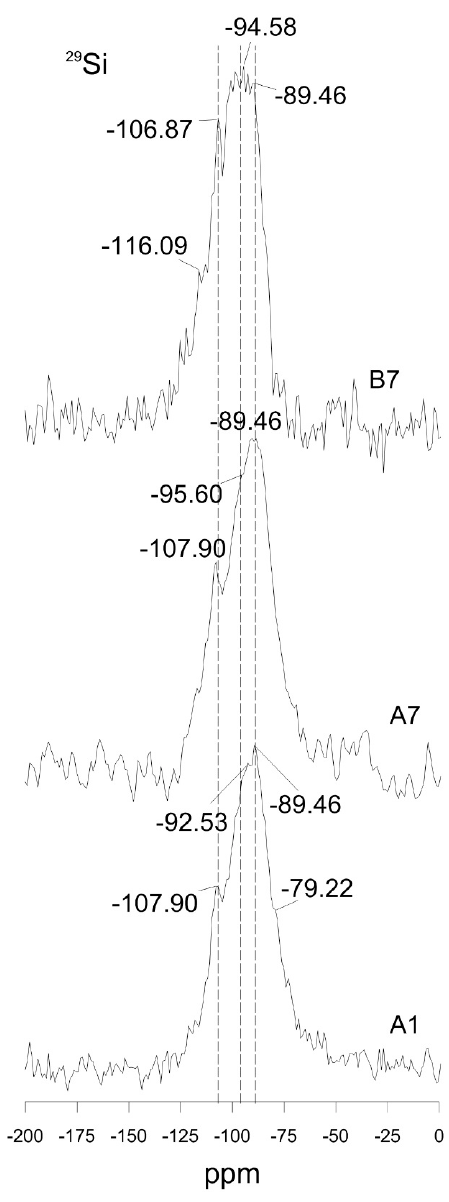
Figure 7. NMR spectra of samples A1, A7 and B7.